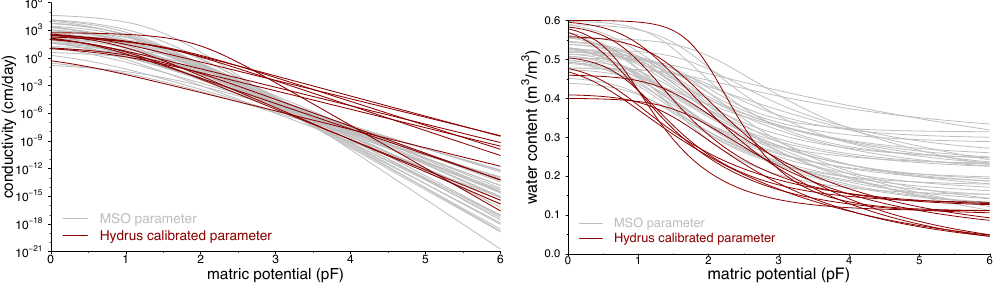
Figure 9. Comparison of the water retention and conductivity functions of the Mualem–van Genuchten parameter sets derived from MSO experiments with those inversely calibrated with Hydrus-1D and SCEM using observed soil moisture time series.